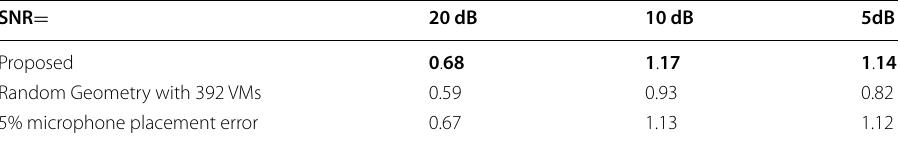
Boldface indicates the best score for each condition